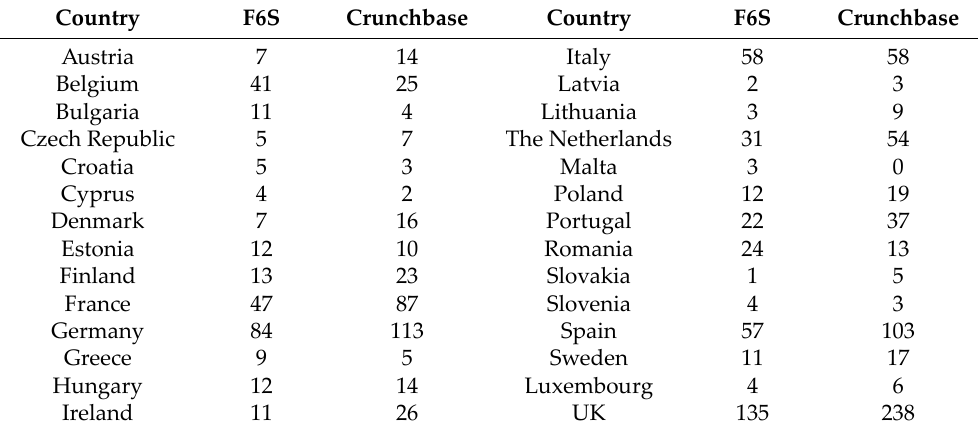
Table 1. Main European Hubs ranked by number of start‑ups accelerators programmes. Country F6S Crunchbase Country F6S Crunchbase